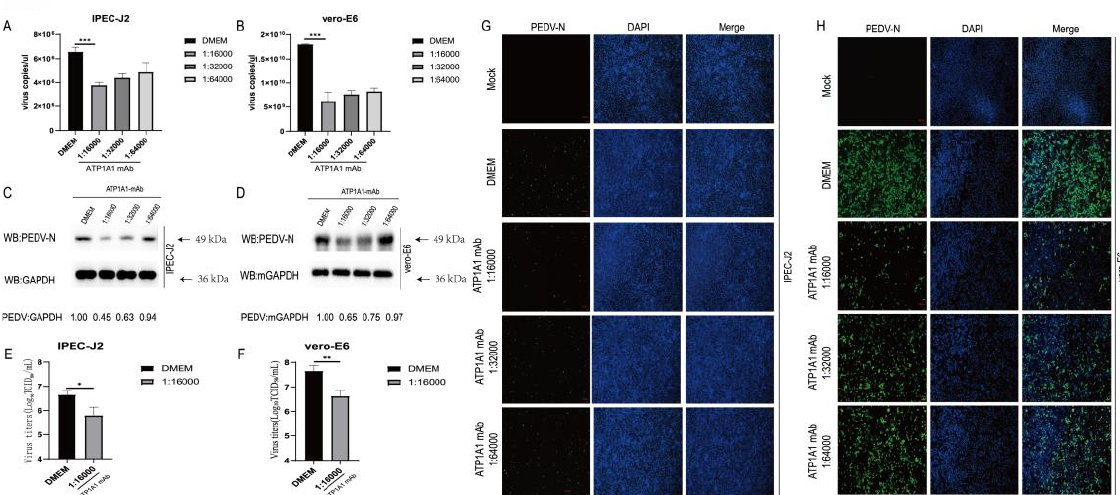
Figure 9. Monoclonal antibody treatment of ATP1A1 effectively reduces PEDV attachment. ( A , B ) Treatment with ATP1A1 mAb effectively reduces PEDV RNA abundance. Cells were incubated with serial diluted ATP1A1 mAb at 37 °C for 1 h. Then, the cells were washed with PBS and incu- bated with PEDV at 0.1 MOI at 4 °C for 1 h. After three washes with PBS, the cells were again incu- bated with the corresponding mAb in DMEM at 37 °C for 24 h. PEDV RNA abundance was deter- mined by RT-qPCR. Data represent means ± SD from three independent experiments. *, p < 0.05; **, p < 0.01; ***, p < 0.001. ( C , D ) ATP1A1 mAb treatment significantly decreases PEDV N protein ex- pression. Pretreatment with different folds of diluted ATP1A1 mAb for 1 h, PEDV at 0.1 MOI in- fected targeted cells for 1 h. Incubation was continued for 48 h in medium containing the corre- sponding dilution of antibody. Cells were lysed for Western blot analysis. ( E , F) ATP1A1 mAb de- creases PEDV viral titers. The experimental processing steps were consistent with Figure 8C. At 48 h, virus yields were determined by TCID 50 assay with Vero-E6 cells. *, p < 0.05; **, p < 0.01. ( G , H ) ATP1A1 mAb inhibits PEDV attachment in targeted cells. The experimental processing steps were consistent with Figure 8C. PEDV-infected cells were determined by immunofluorescence staining with anti-PEDV-N mAb (green). Staining of cell nuclei using DAPI (blue) staining solution. Scale bars, 100 µ